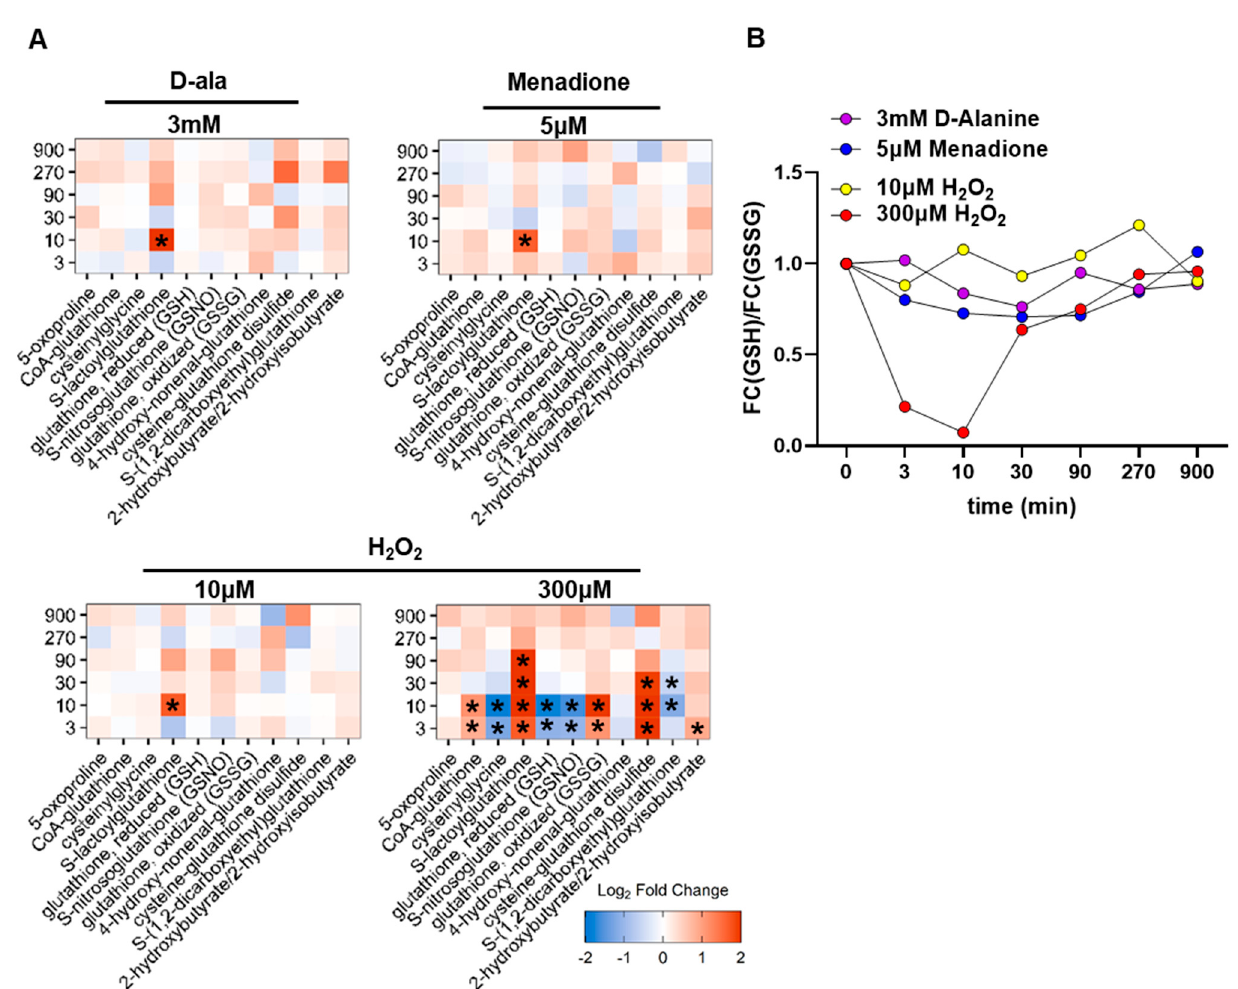
Figure 3. Changes in glutathione and glutathione-related metabolites in HUVEC upon exposure to different ROS. ( A ): Time course metabolic changes in glutathione metabolism. ( B ): Glutathione redox state in HUVEC over the course of time treatment with oxidative stimuli. FC = fold change. A&B: n = 3. * p -value <